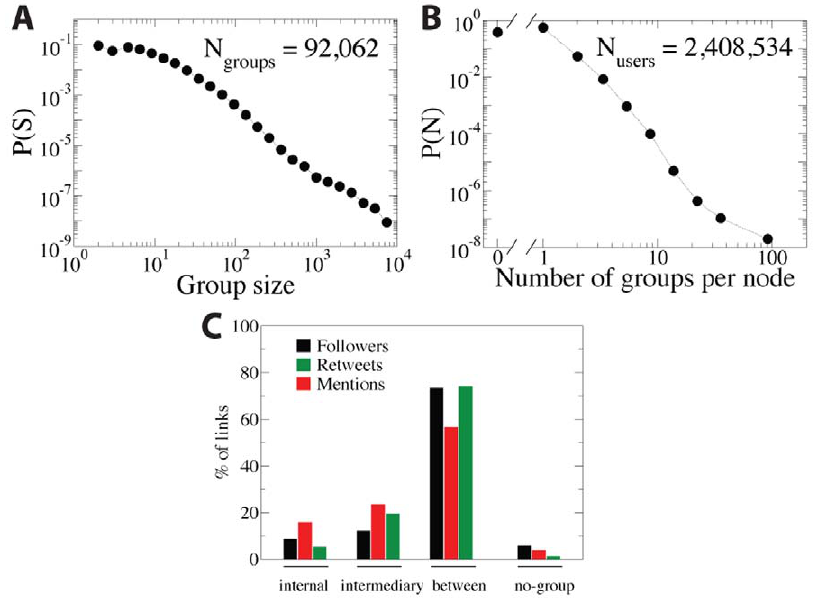
Figure 2. Group and link statistics. (A) Size distribution of the group. (B) Distribution of the number of groups to which each user is assigned. (C) Percentage of links of different types, e.g. follower links (black bars), links with mentions (red bars) or retweets (green bars), staying in particular topological localizations in respect to detected groups.